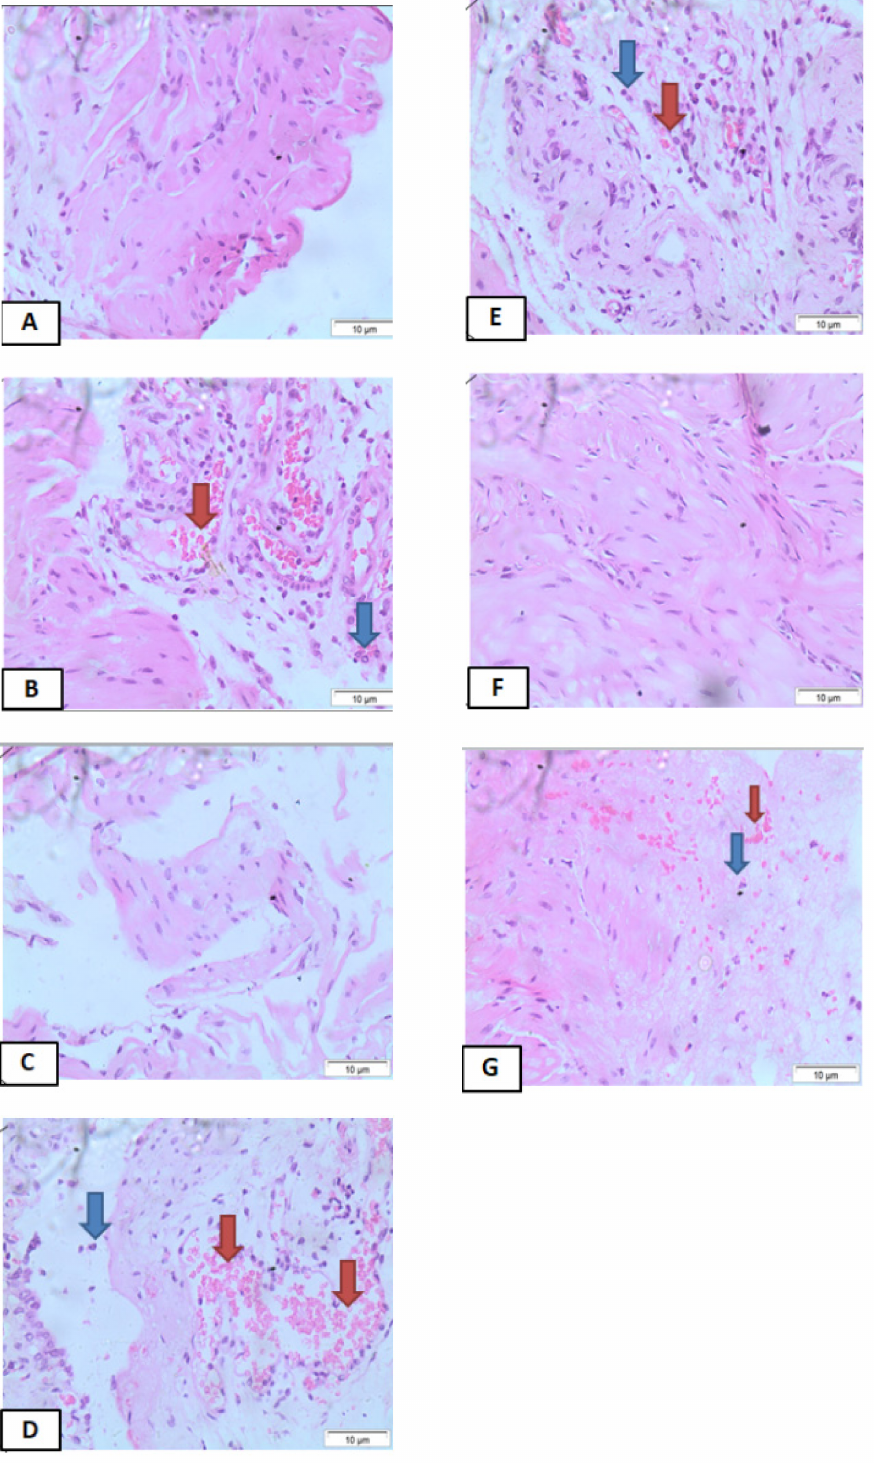
Figure 4. Effects of IPG on histopathological changes in bladder tissues of mice with ifosfamide- induced hemorrhagic cystitis. Representative histological alterations of the bladders of the mice of different groups. ( A ) Control group (Sham). ( B ) IFOS group. ( C ) IFOS + Mesna (160 mg/kg) group. ( D – G ) Test groups IFOS + IPG (6.25, 12.5, 25, or 50 mg/kg, respectively). The ar- rows indicate: hemorrhage ( ) (Hematoxylin and Eosin staining, × 400